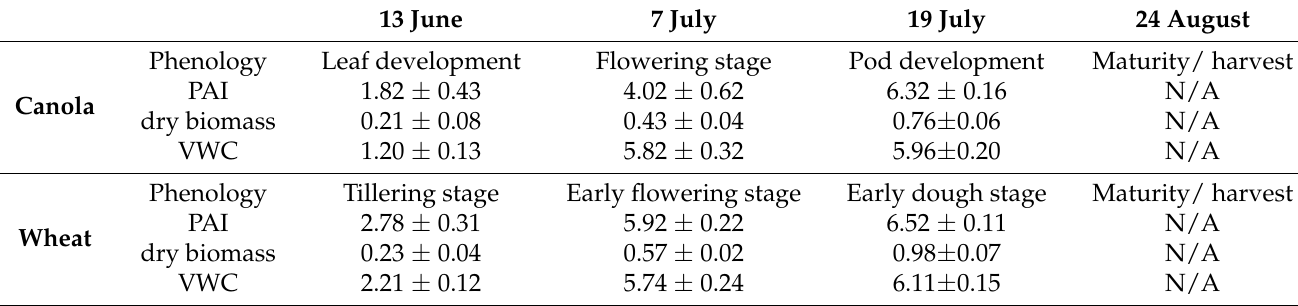
Table A2. Temporal variations of Plant Area Index (PAI), dry biomass (kg m − 2 ), and Vegetation Water Content (VWC) (kg m − 2 ) for canola and wheat at different